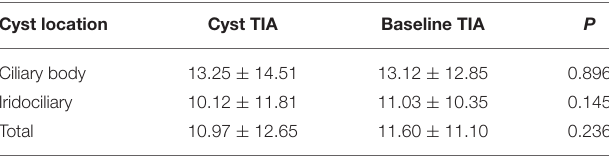
significant difference between the left and right eyes ( P LD = 0.192, P CVD = 0.145).